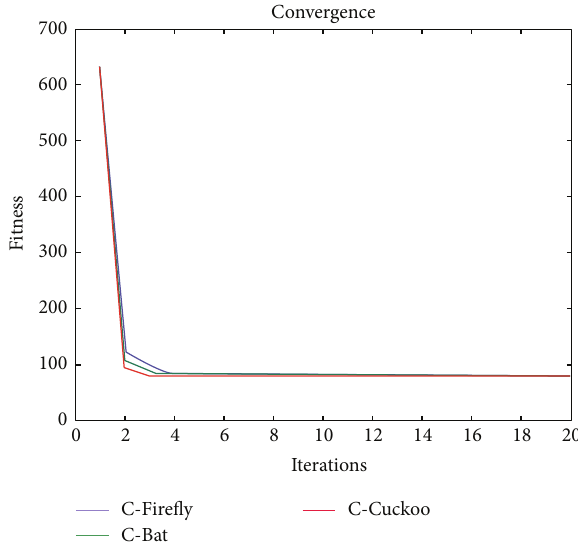
Figure 7: Number of iterations required for C-Firefly, C-Cuckoo, and C-Bat algorithms to converge.